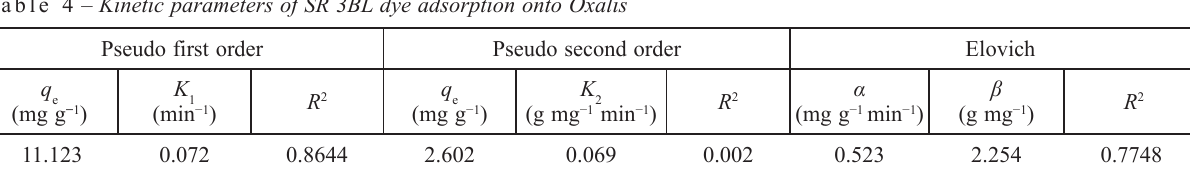
Table 4 – Kinetic parameters of SR 3BL dye adsorption onto Oxalis